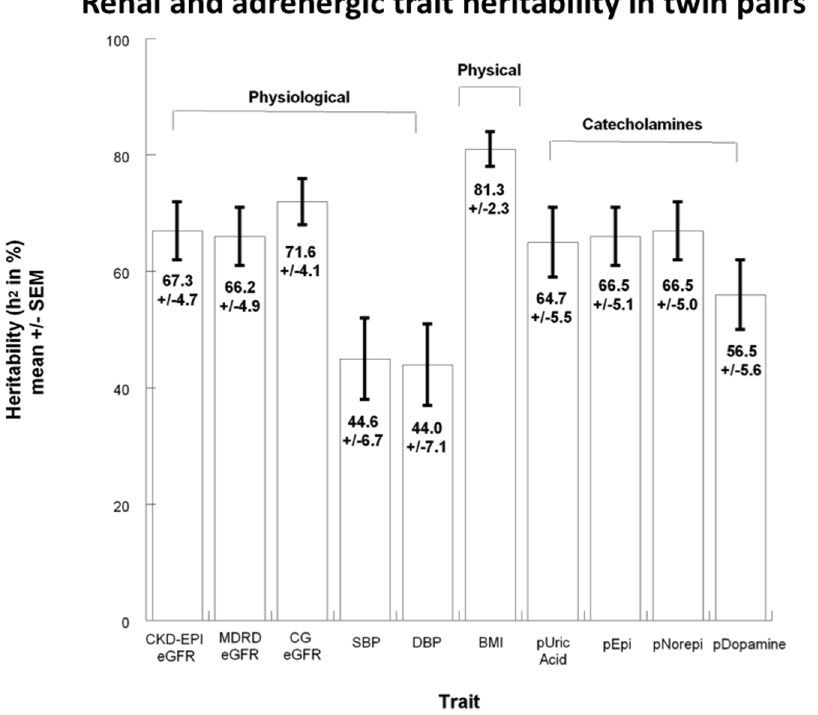
Figure 2. Heritability h 2 and genetic covariance: Heritability (h 2 ) estimates of CKD-EPI estimated glomerular filtration rate (eGFR) and renal, physiological, physical and catecholamine risk factors in the twin study cohort. The h 2 estimates, expressed as % ( 6 standard error of mean) of trait variance (h 2 =V G /V P ), obtained using SOLAR, suggest general agreement of the present cohort with other previously published research. h 2 estimates arose from n=340 (renal traits) to n=357 (adrenergic traits) individuals. BMI indicates body mass index; SBP, systolic blood pressure; DBP, diastolic blood pressure; pEpi, plasma norepinephrine; pNorepi, plasma norepinephrine; pDopamine, plasma dopamine; CKD-EPI, Chronic Kidney Disease Epidemiology Collaboration formula; CG, Cockroft-Gault formula; MDRD, Modification of Diet in Renal Disease study